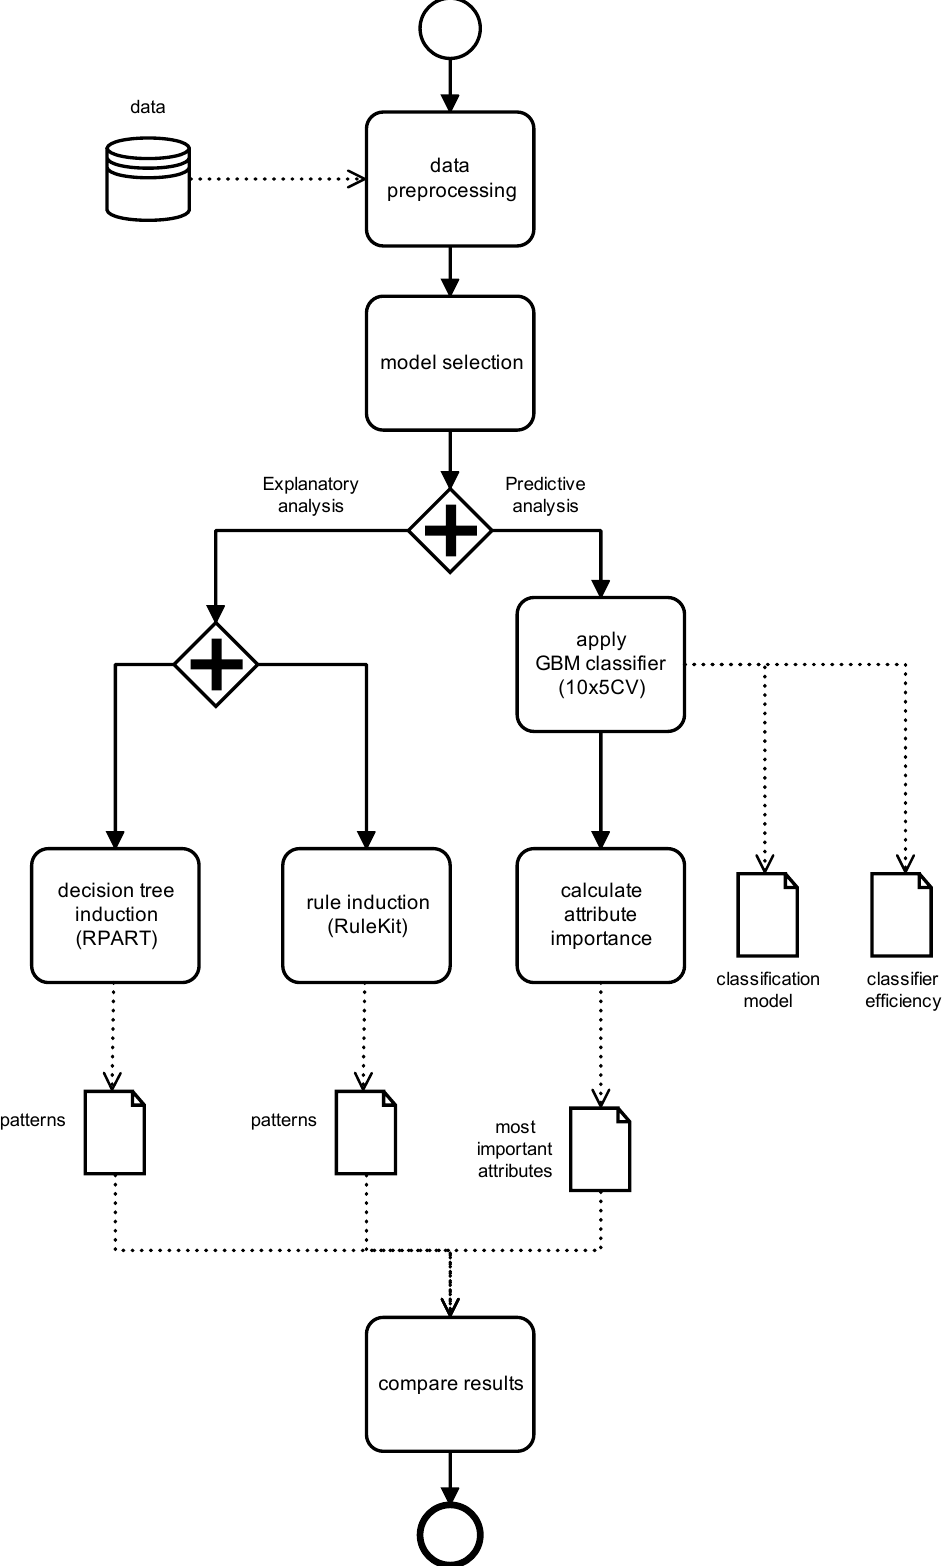
Figure 3. Descriptive and predictive analysis